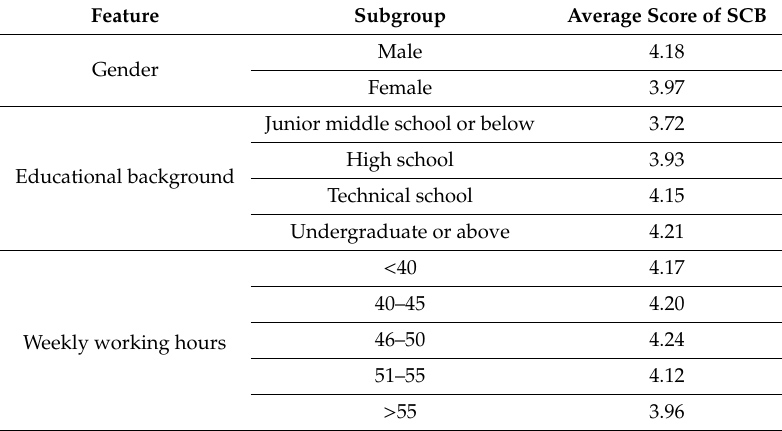
Table 16. Average score of safety citizenship behaviour (SCB) for subgroups with significant di ff erences in